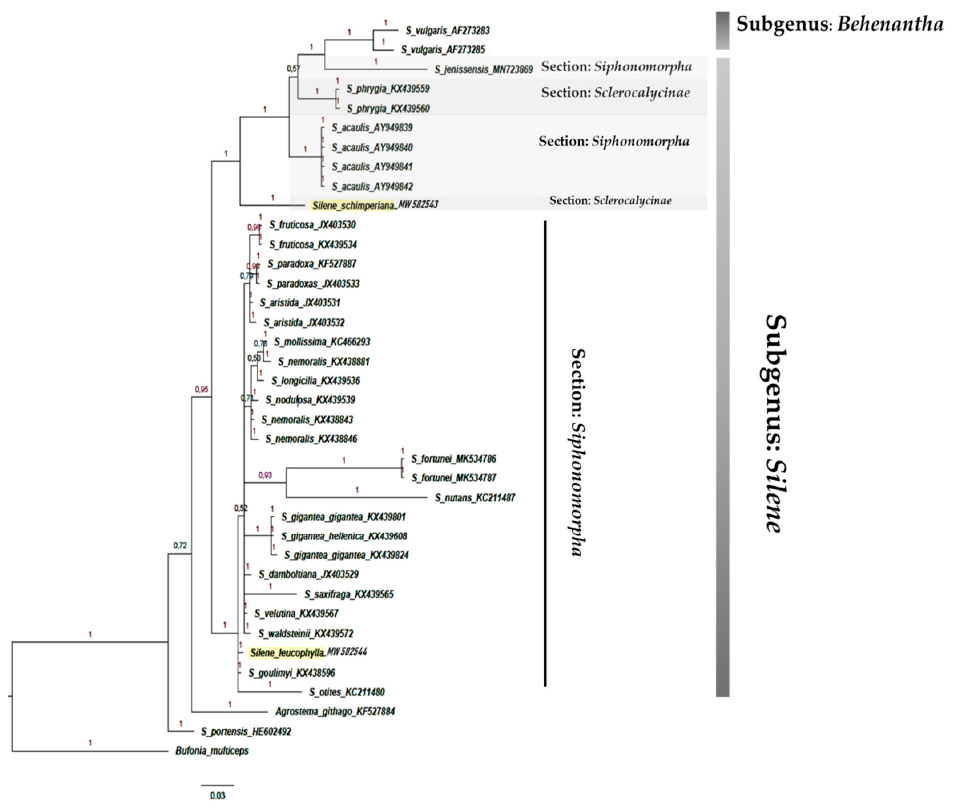
Figure 10. Bayesian phylogenetic tree of Silene species based on cpDNA sequences of the psb -A/ trn -H marker. Numbers above branches represented (PP).